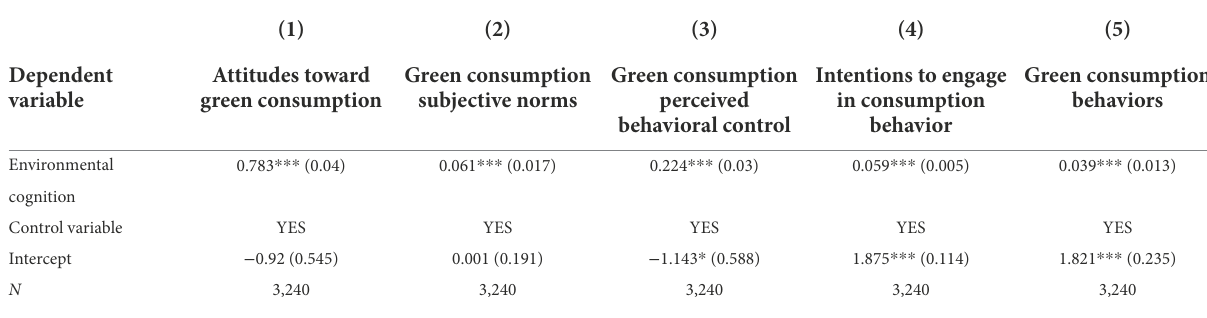
TABLE 6 Estimation results of the multilayer linear model considering the eastern region.